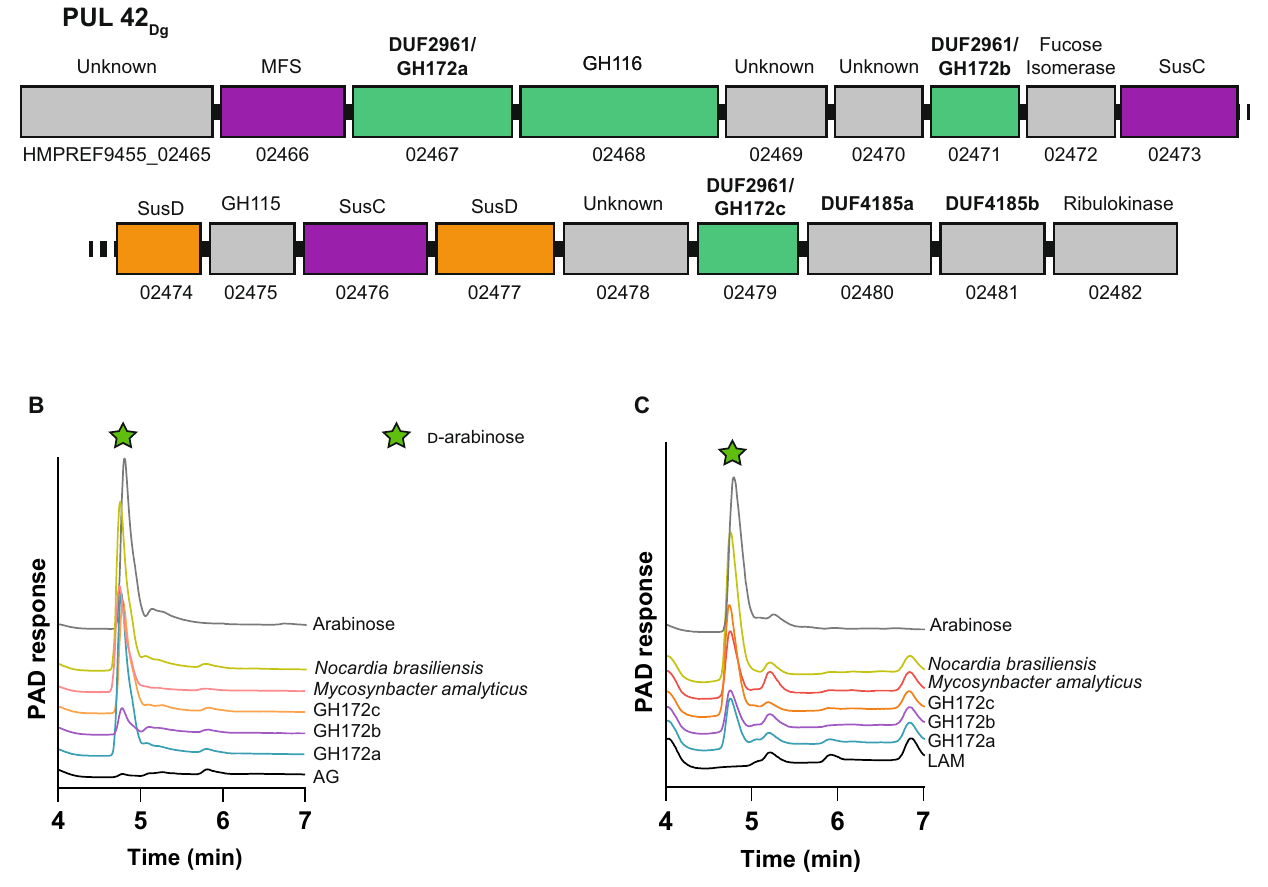
sodiumacetategradientover60minutes.Greenstar= D -arabinose.Sourcedataare provided in the Source Data fi